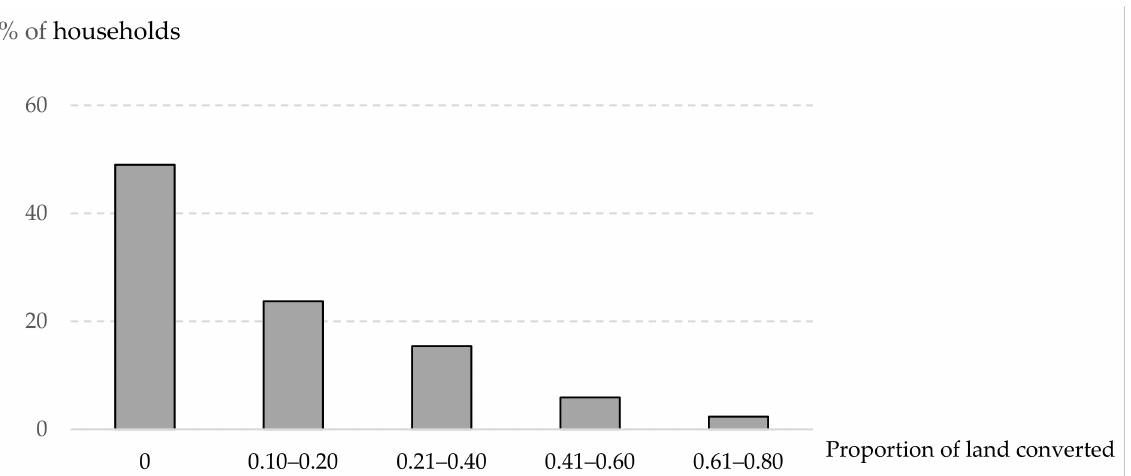
Figure 3. Percentage of households that converted farmland to the HPRS to varying extents in northern